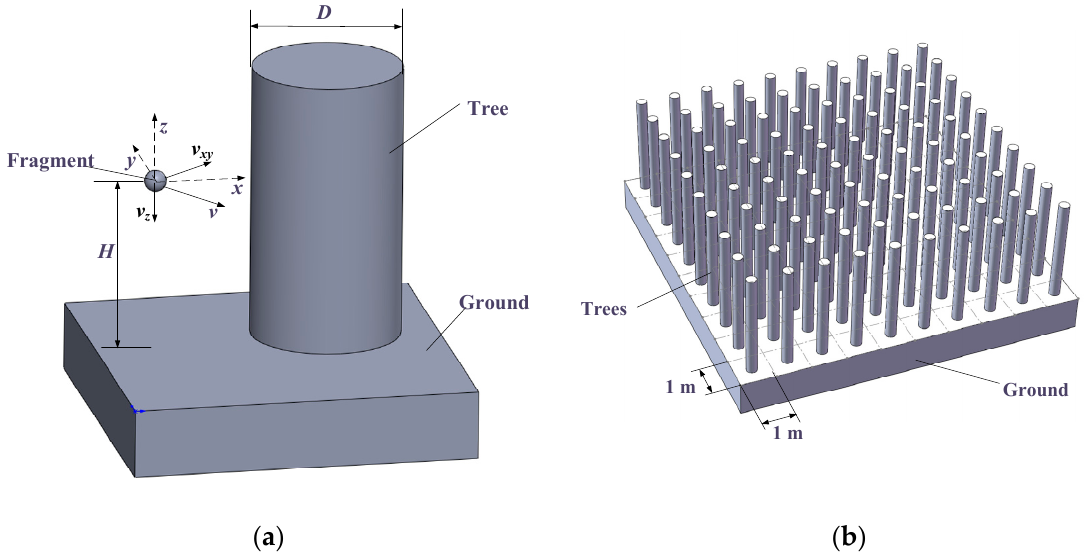
Figure 5. Model of fragment penetrating trees in forest. ( a ) This is a schematic diagram of fragments